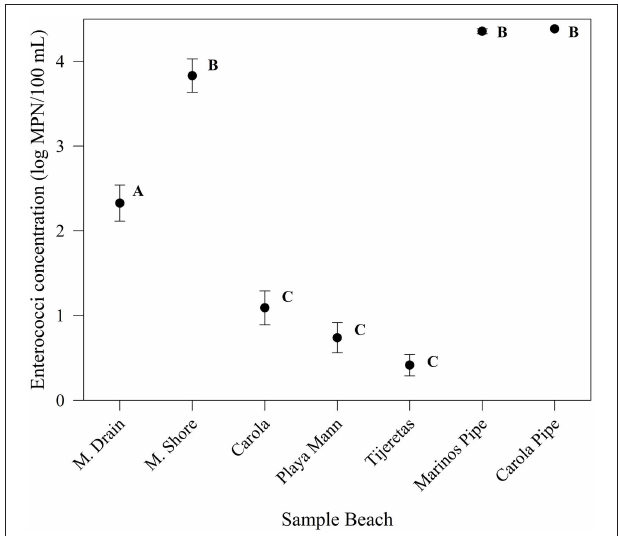
FIGURE 2 | Enterococci concentrations on sample beaches. Circles represent means and bars represent standard error in either direction. Letters indicate sites that are not significantly different from each other at p < 0.01 . P -values are reported from rank-transformed ANOVA for Enterococcus levels for each beach and adjusted using the Bonferroni